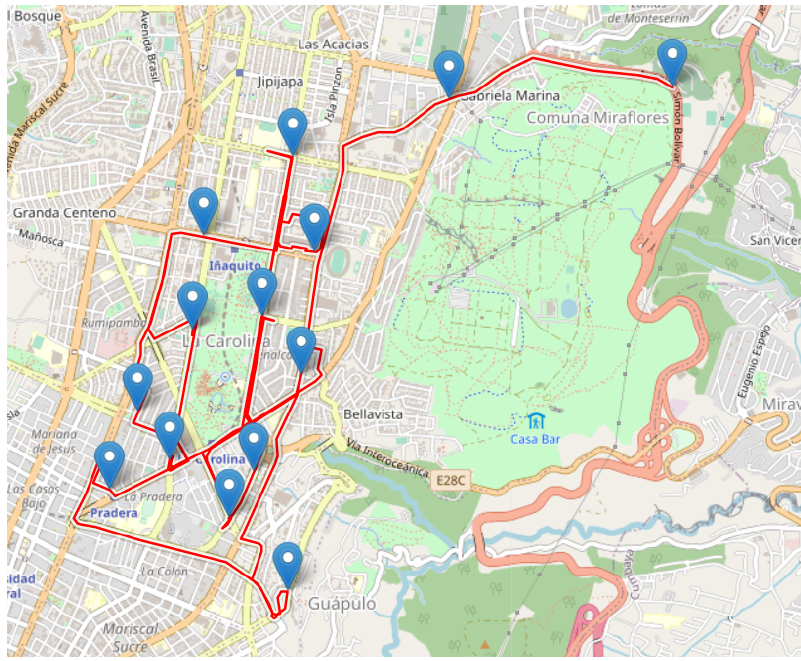
Figure 15. Resulting route of the algorithm. (blue icons are the way-points) Table 2. Patrol Route Selection Data with CPSPA